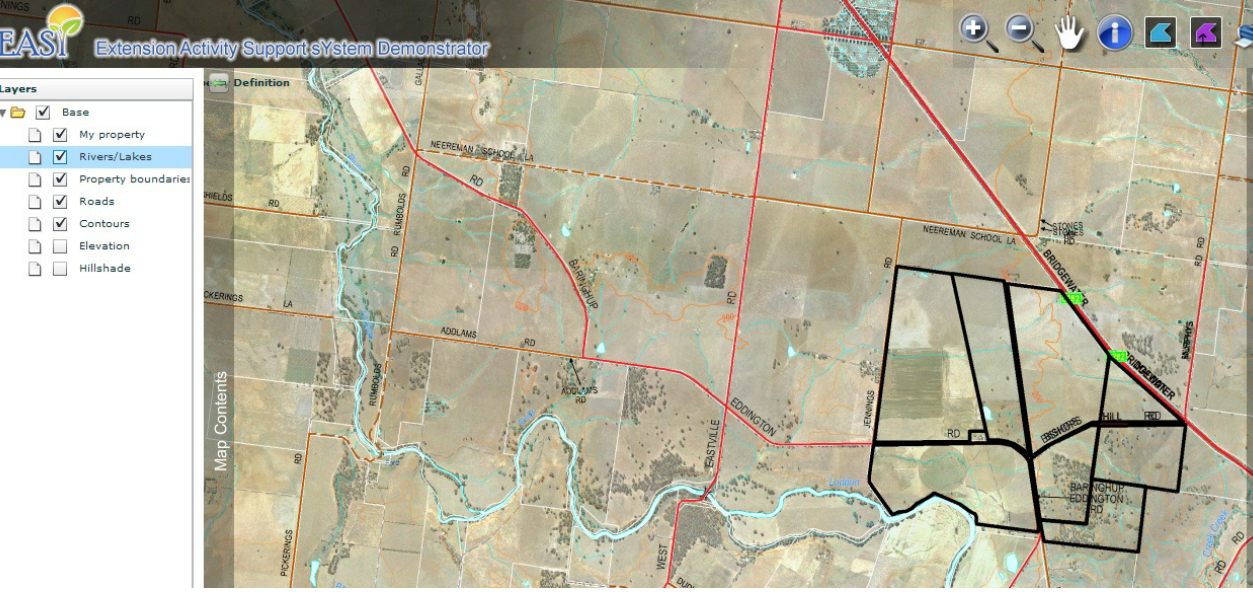
Figure 4. EASY prototype topic package with aerial imagery and polygonal data illustrating property boundaries, water courses and road